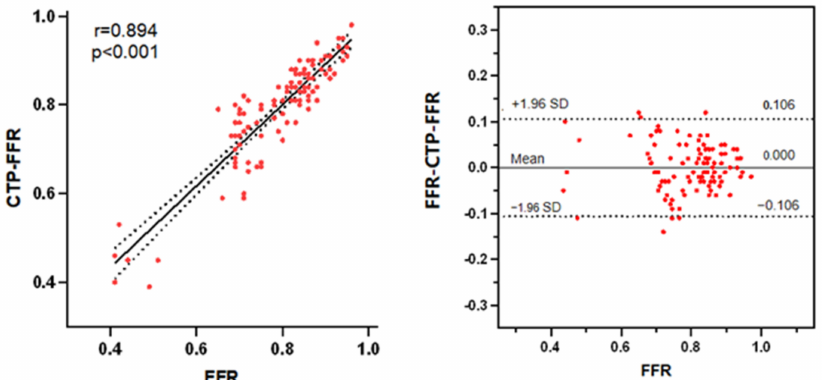
Figure 4. ( Left ) A strong correlation (R = 0.894) is observed between CTP-FFR and FFR. ( Right ) Bland– Altman analysis of FFR and CTP-FFR on a per-vessel basis. The distribution of red points represents the correlation and consistency of CTP-FFR with FFR. Abbreviations same as in Figure 1.